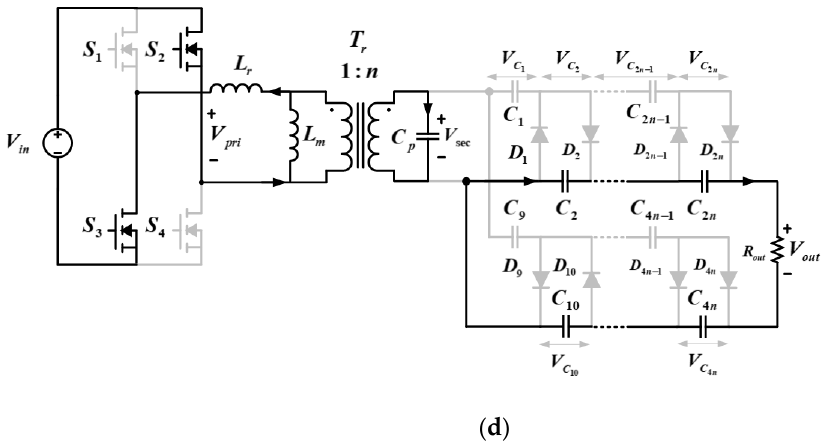
Figure 2. Operation mode of the proposed parallel resonant converter: ( a ) MODE 1 [𝑡 0 − 𝑡 1 ] ; ( b )